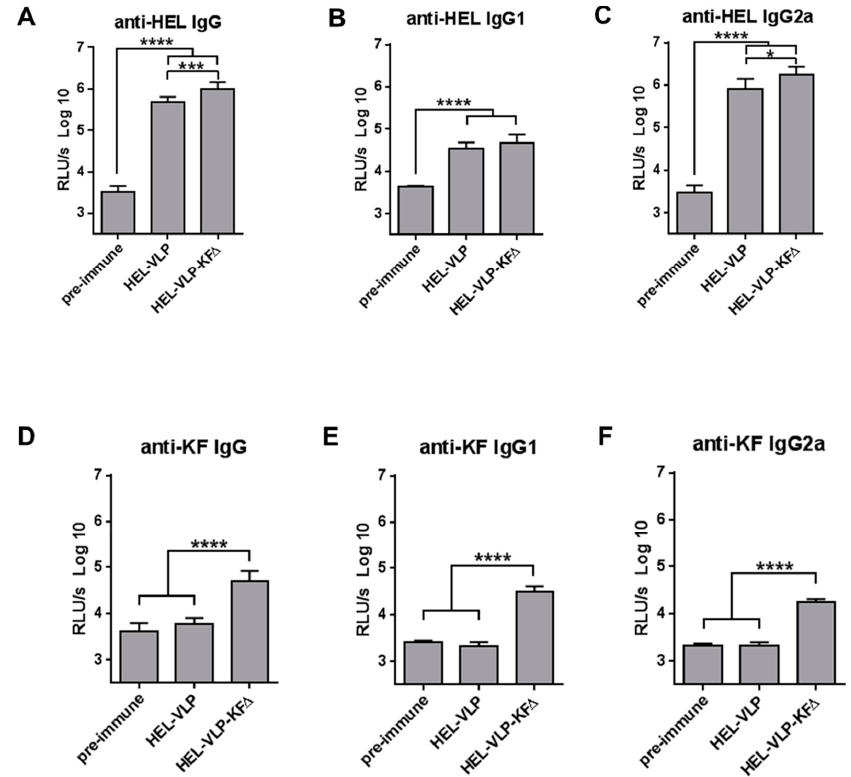
Figure 4. Induction of humoral immune responses in C3H mice with HEL-VLP nano-vaccines functionalized with KF ∆ . Wt C3H mice were immunized i.m. twice (at day 0 and day 35) with either HEL-VLP or HEL-VLP-KF ∆ containing 400 ng of HEL / mouse. The sera samples were obtained at day 0 before immunization (pre-immune sera) and at day 49 (2 weeks after the second immunization). Humoral immune responses against HEL ( A–C ) and KF ( D–F ) were measured in 1:100 diluted sera samples and expressed as log10-transformed relative light units per second (RLU/s log10). Each experimental group included six mice. the pre-immune sera group contains samples of 12 mice correspondingly. The columns represent the mean values ± SEM. *p = 0,0169; ***p = 0.0009; ****p < 0.0001; one-way ANOVA with Tukey multiple comparison post-hoc test.